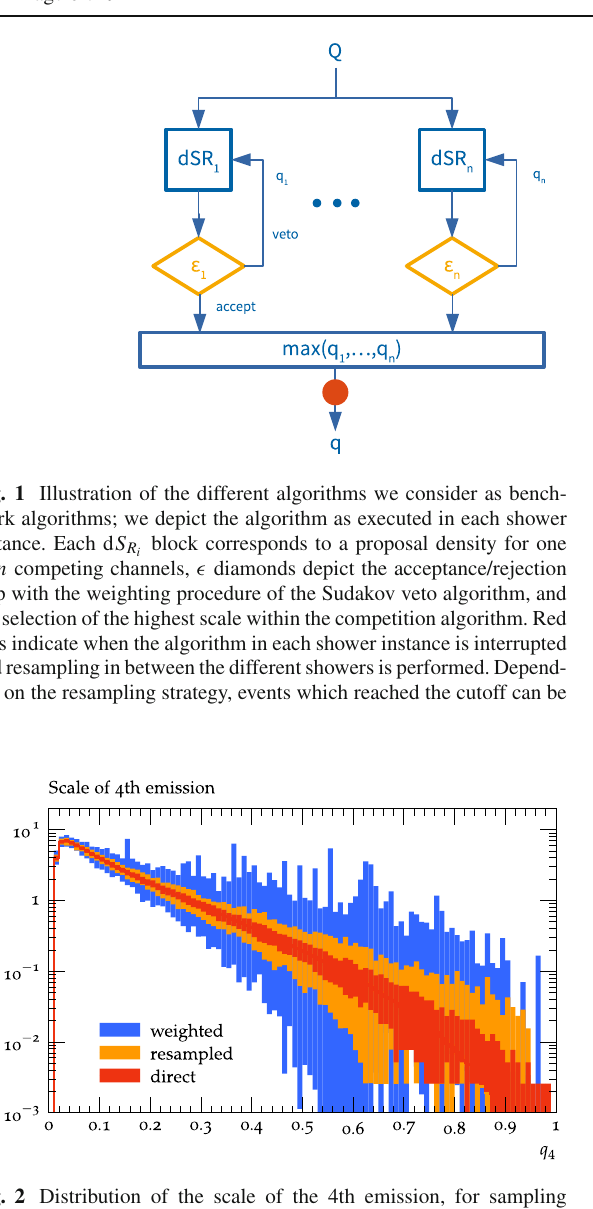
Fig. 2 Distribution of the scale of the 4th emission, for sampling the distribution with the competition algorithm splitting a into a sum across 10 different competing channels, with red being the direct algo- rithm, blue the weighted Sudakov algorithm and orange the resampled, weighted Sudakov algorithm. The bands in the distribution reflect the minimum and maximum estimate encountered in 300 runs with differ- ent random seeds and thus give a rough estimate of the width of the distribution of